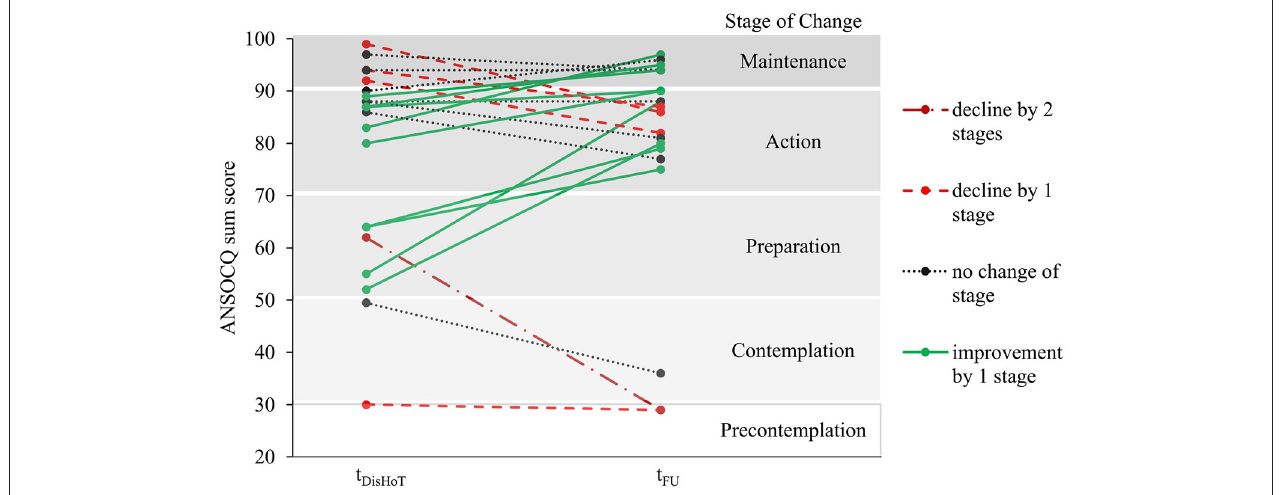
FIGURE 2 | Change in motivational stages of the ANSOCQ of the individual patients between discharge from home treatment and follow-up. ANSOCQ, anorexia nervosa stages of change questionnaire; t DisHOT , discharge from home treatment; t FU , follow-up.